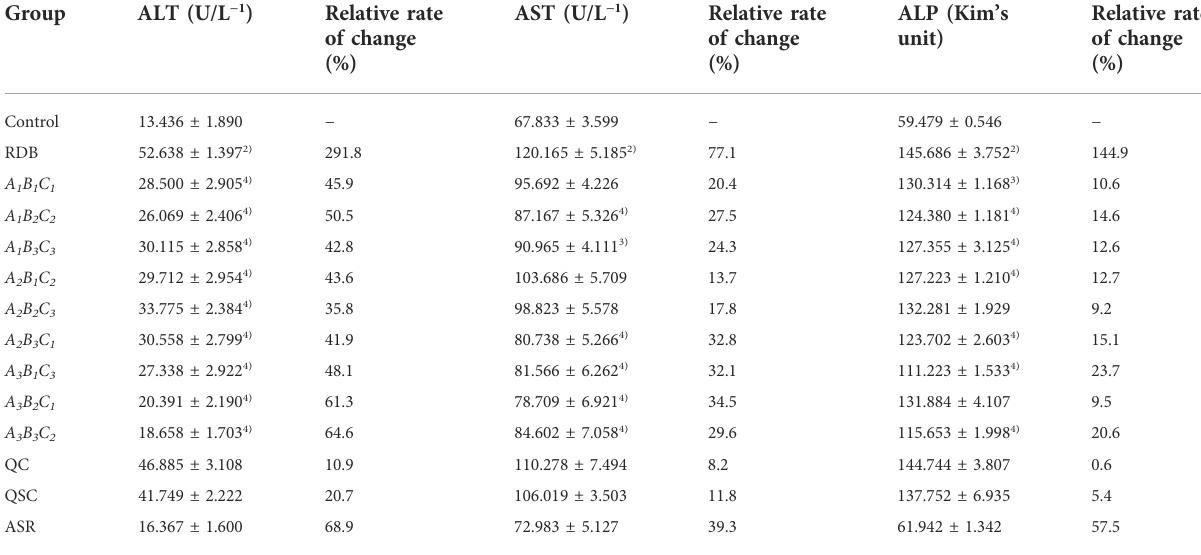
TABLE 3 Processing with ASR reversed the signi fi cantly elevated serum biochemical levels induced by RDB. Group